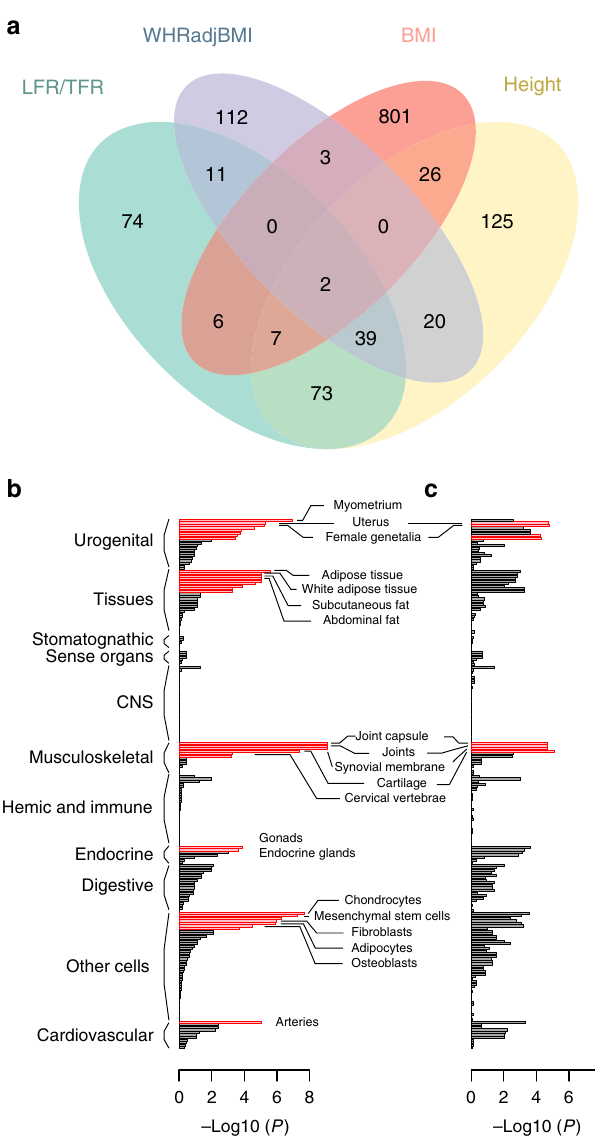
Fig. 3 Enrichment analyses of genes at LFR and TFR-associated loci. a Reconstituted gene-sets that were enriched for TFR- and LFR-associated genes (in both males and females) were compared to results from previous GWAS on WHRadjBMI 12 , BMI 9 , and height 20 . Tissue and cell type enrichment of b TFR- and c LFR-associated genes in females. Red bars denote tissues gene sets that were signi fi cantly enriched for LFR- and